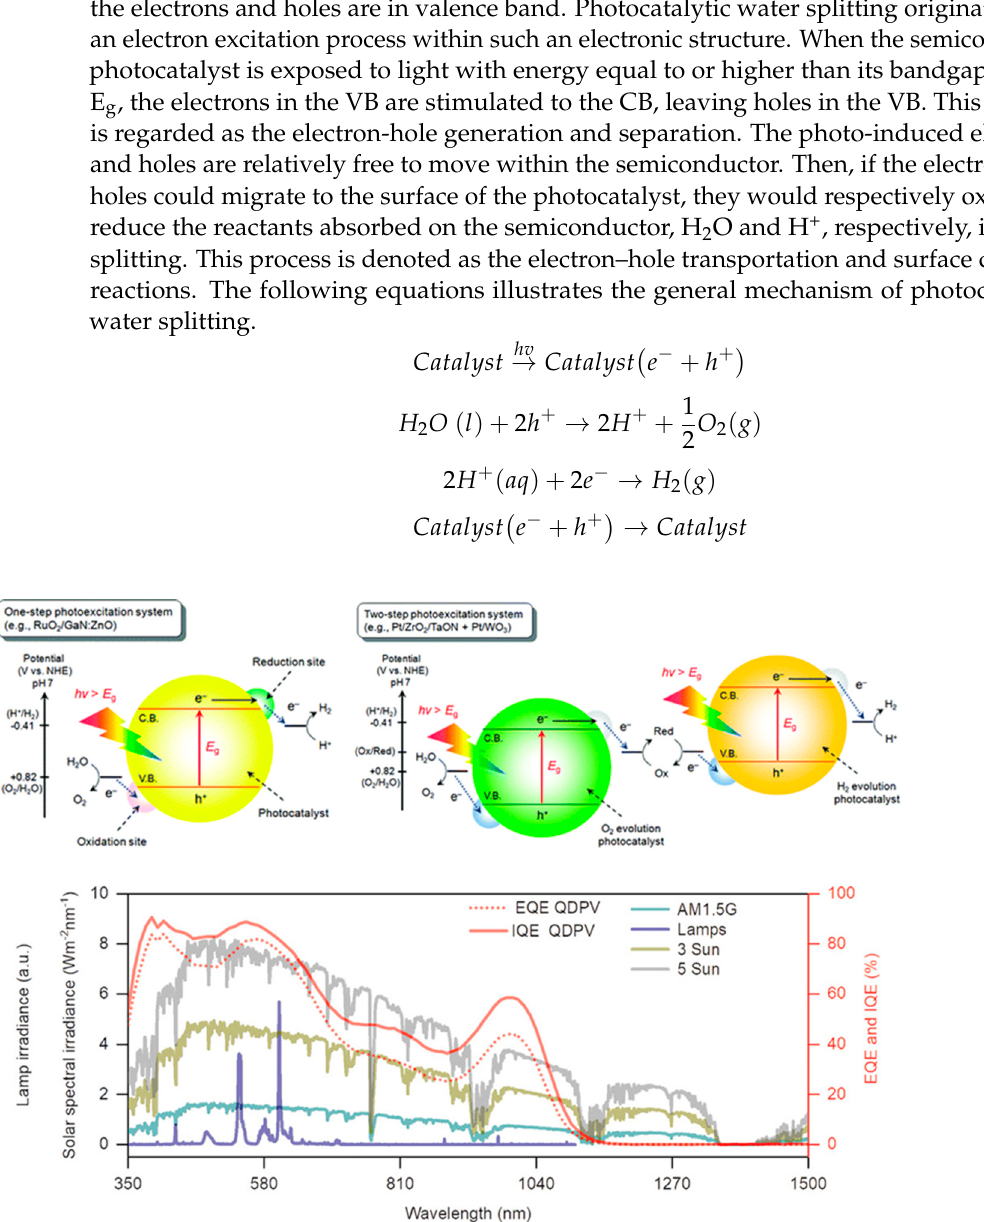
Figure 1. ( a ) Reaction scheme of one-step and two-step excitation process of photocatalytic water splitting. ( b ) The spectra of solar irradiance, a fluorescent lamp (1000 lux), and examples of the external and internal quantum efficiency spectra (1.24 eV lead sulphide quantum dots). Reproduced from [21], Copyright 2010, American Chemical Society.